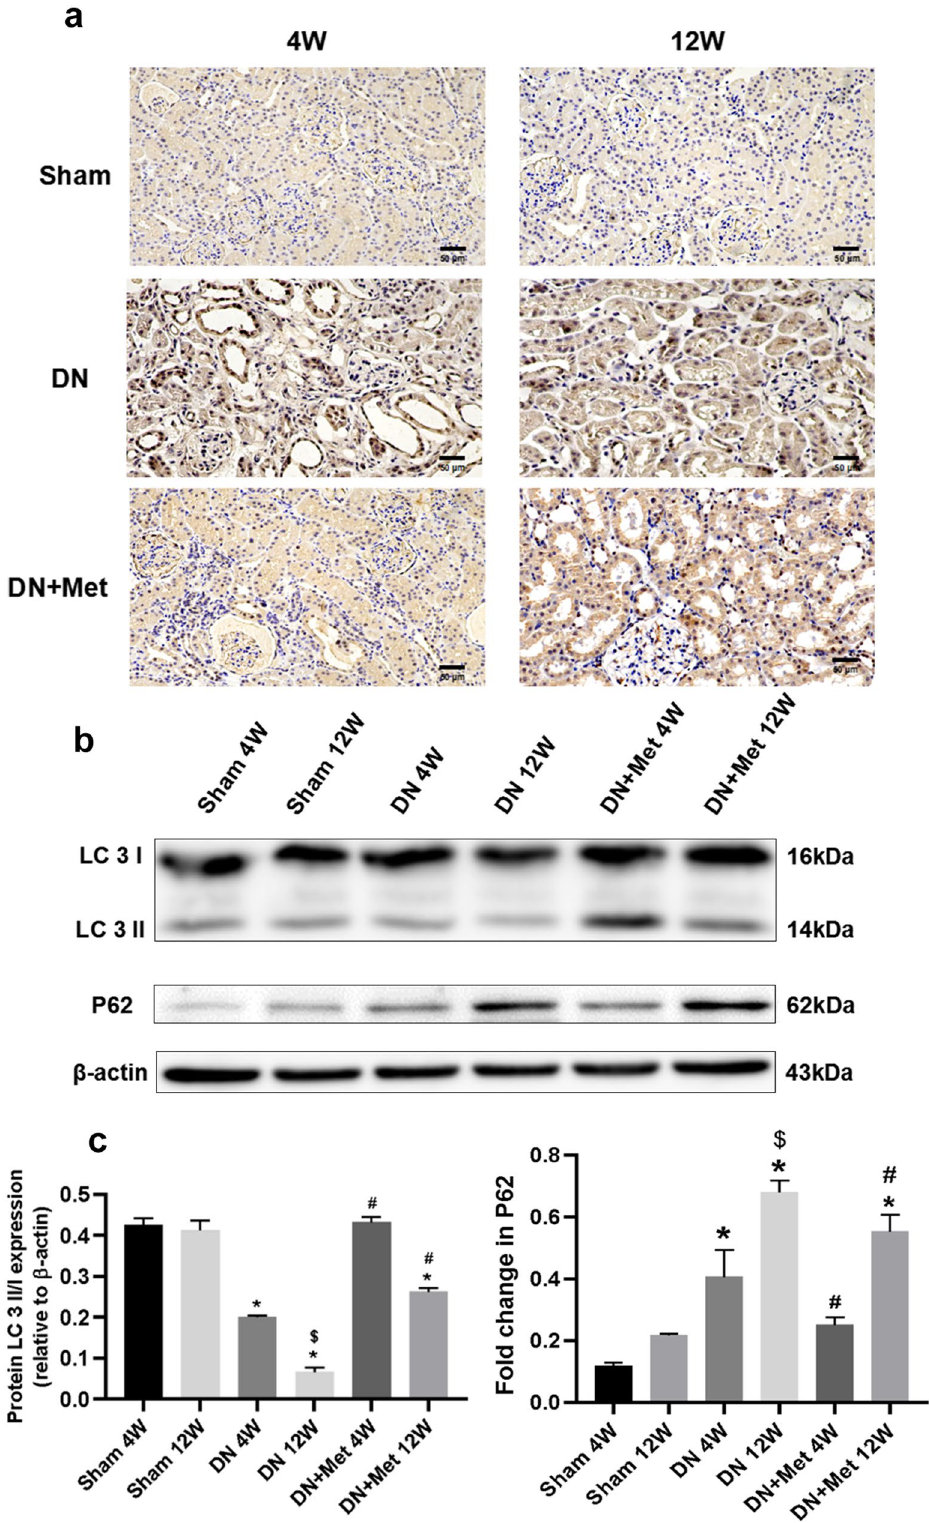
Figure 3. Effects of metformin on the level of autophagyin DN kidneys. ( a ) The level of P62 was measured using immunohistochemistry under a microscope. Scale bar represents 50 μm. ( b ) Expression of LC3 I and LC3 II based on immunoblotting and normalized to β-actin. The boxes indicate images from different gels, but the samples derived from the same experiment and blots were processed in parallel. ( c ) Statistical analysis of the expression of P62 and LC3 II/LC3 I in each group. * P < 0.01 vs. 4-week Sham group and 12-week Sham group by ANOVA, # P < 0.01 vs. 4-week DN group and 12-week DN group by ANOVA, $ P < 0.05 vs. 4-week DN/DN + Met group by ANOVA. 4W: 4-week; 12W: 12-week; Met: metformin. Full- length blots were presented in Supplementary